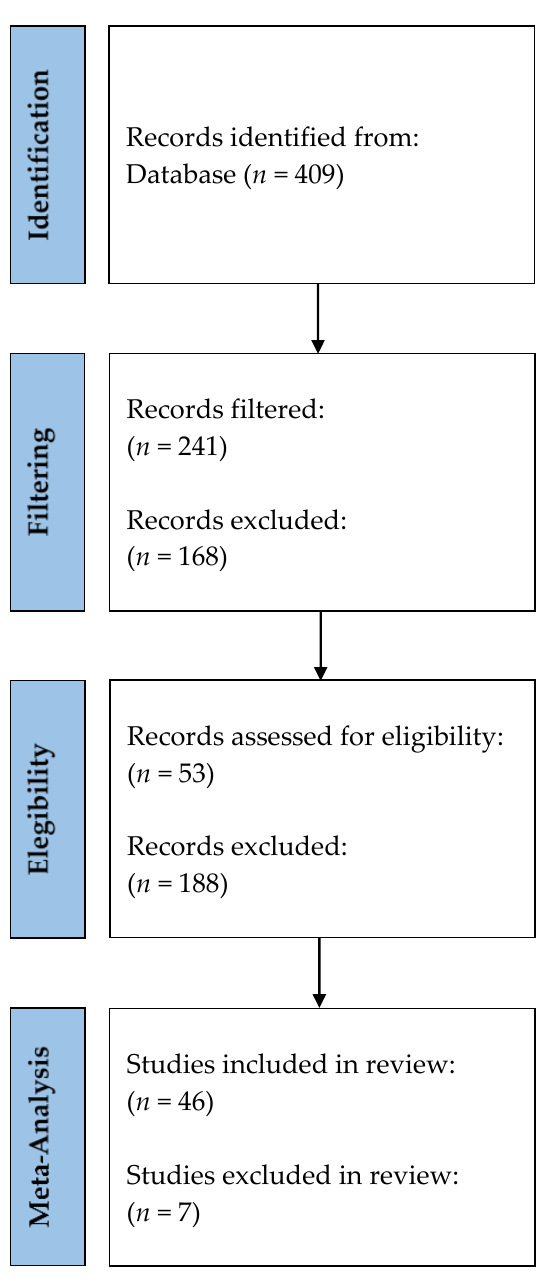
Figure 1. Flow chart of criteria for the selection of documents analysed.